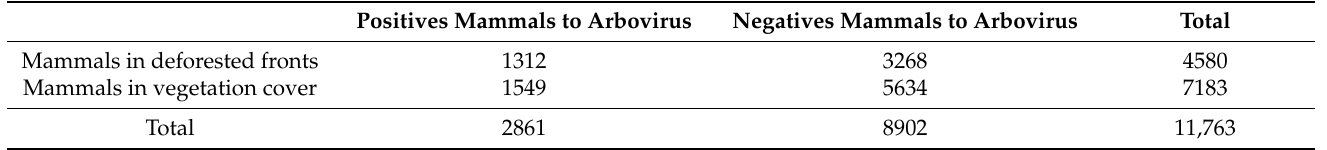
Table 6. Mammals positive to arbovirus in Neotropical countries and occurrence according to hab- itat.